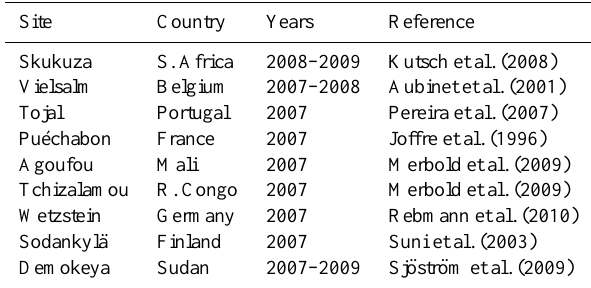
Table 2. In-situ eddy covariance observations used in this